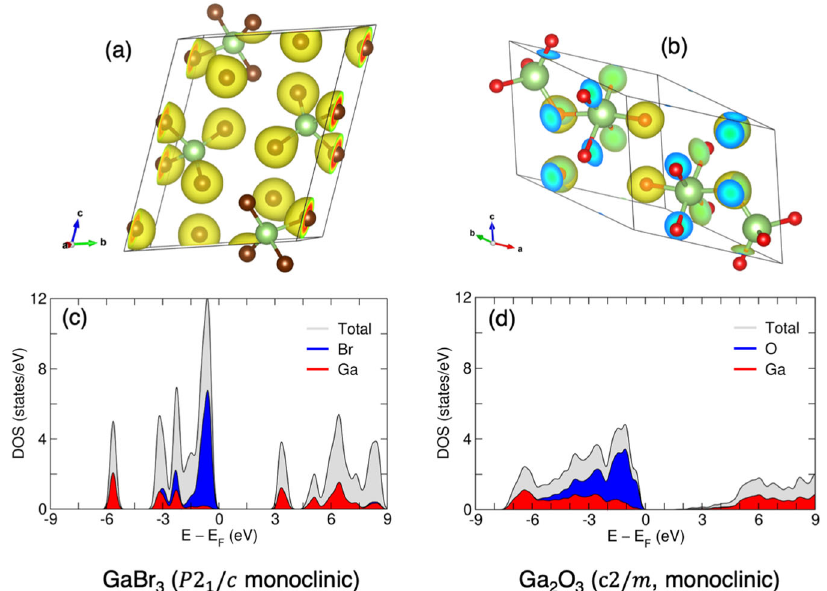
Fig. 4 Electronic structure of selected compounds. The crystal structure and the charge densities of GaBr 3 and Ga 2 O 3 are shown in ( a ) and ( b ). The atom-projected electronic density of states for GaBr 3 and Ga 2 O 3 are shown in ( c ) and ( d ).